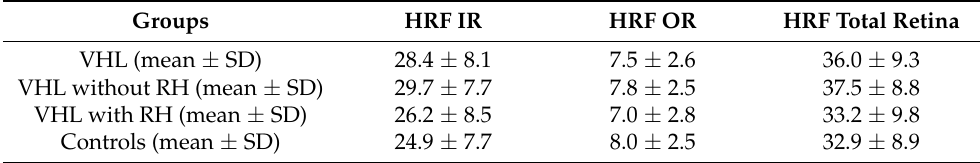
Table 10. HRF in internal, external and total retina in the analyzed groups. Groups